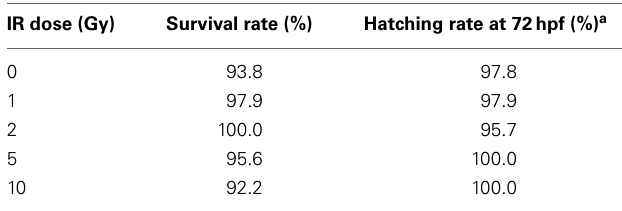
Table 1 | Survival and hatching rate of zebrafish following developmental IR